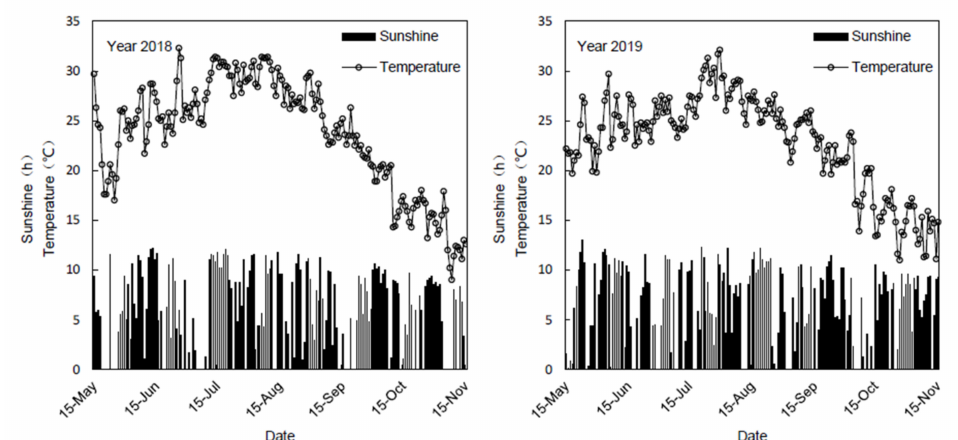
Figure 2. Average sunshine hours and temperature during rice growth season of 2018 and 2019 in the experimental